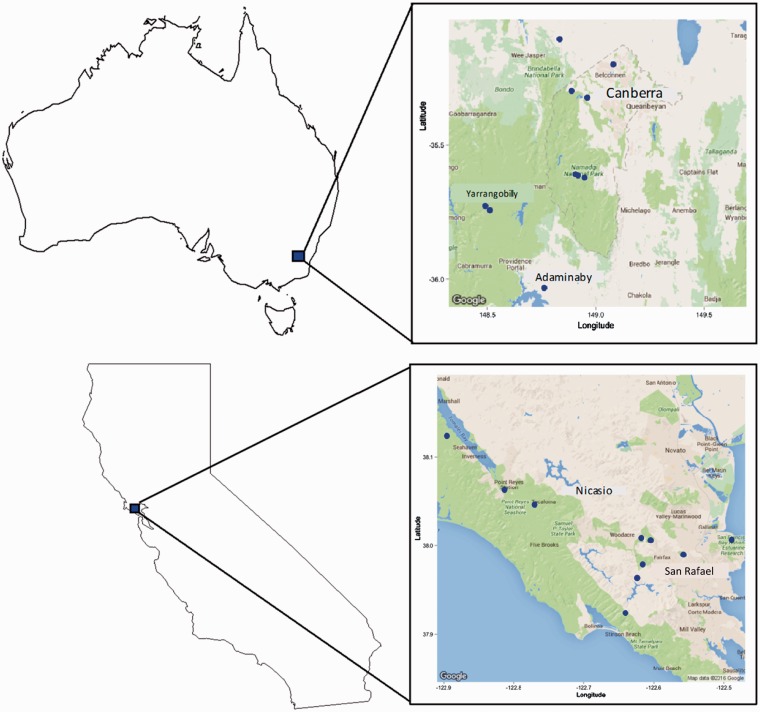
Soil inoculation collection sites in Australia (top) and California (bottom). Maps created using the R statistical package “ggmap” version 2.5.2 (Kahle and Wickham 2013).